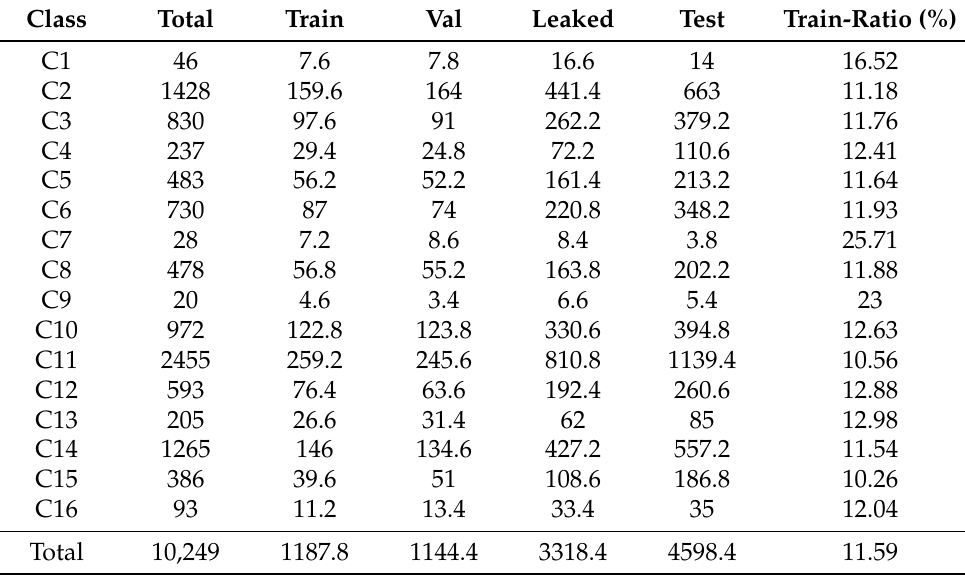
Table 3. Average number of training/validation/leaked/test pixels in Indian